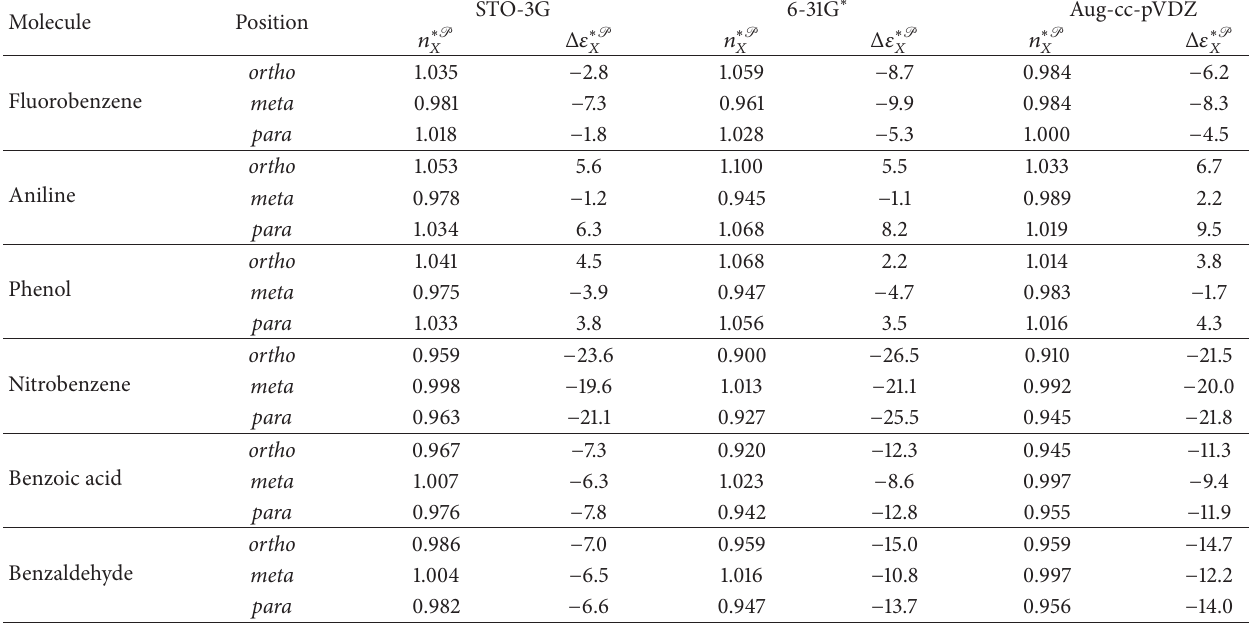
Table 3: Occupation numbers (11) and differences between the highest NO “energies” (15) in [kcal ⋅ mol − 1 ] for benzene and its derivatives, calculated within representation of “physically” orthogonalized atomic orbitals. For asymmetric species, the position refers to carbon